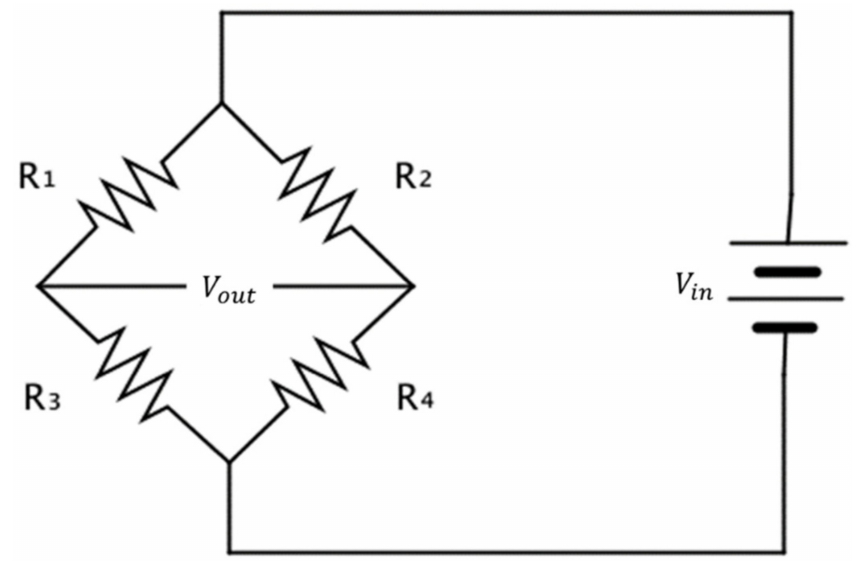
Figure 3. Wheatstone bridge